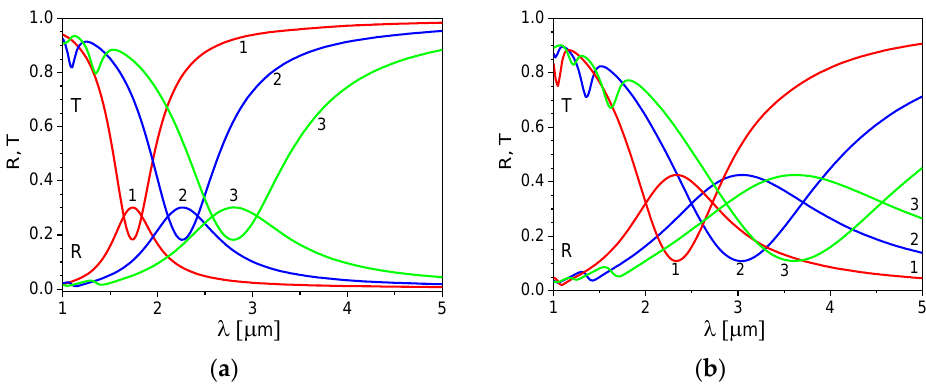
n = 5 × 10 19 m −2 , and the director 134 2 D